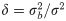
Average LOD scores across 100 replications under different block variances.The arrow size and direction represent the approximate effect size and direction of a QTL, respectively. (A) δ = 0.5; (B) δ = 1; (C) δ = 5; (D) δ = 10. δ represents the size of the block variance and is defined as δ=σb2/σ2, where σ
2 is the error variance and σb2 is the variance of a block within the replication.